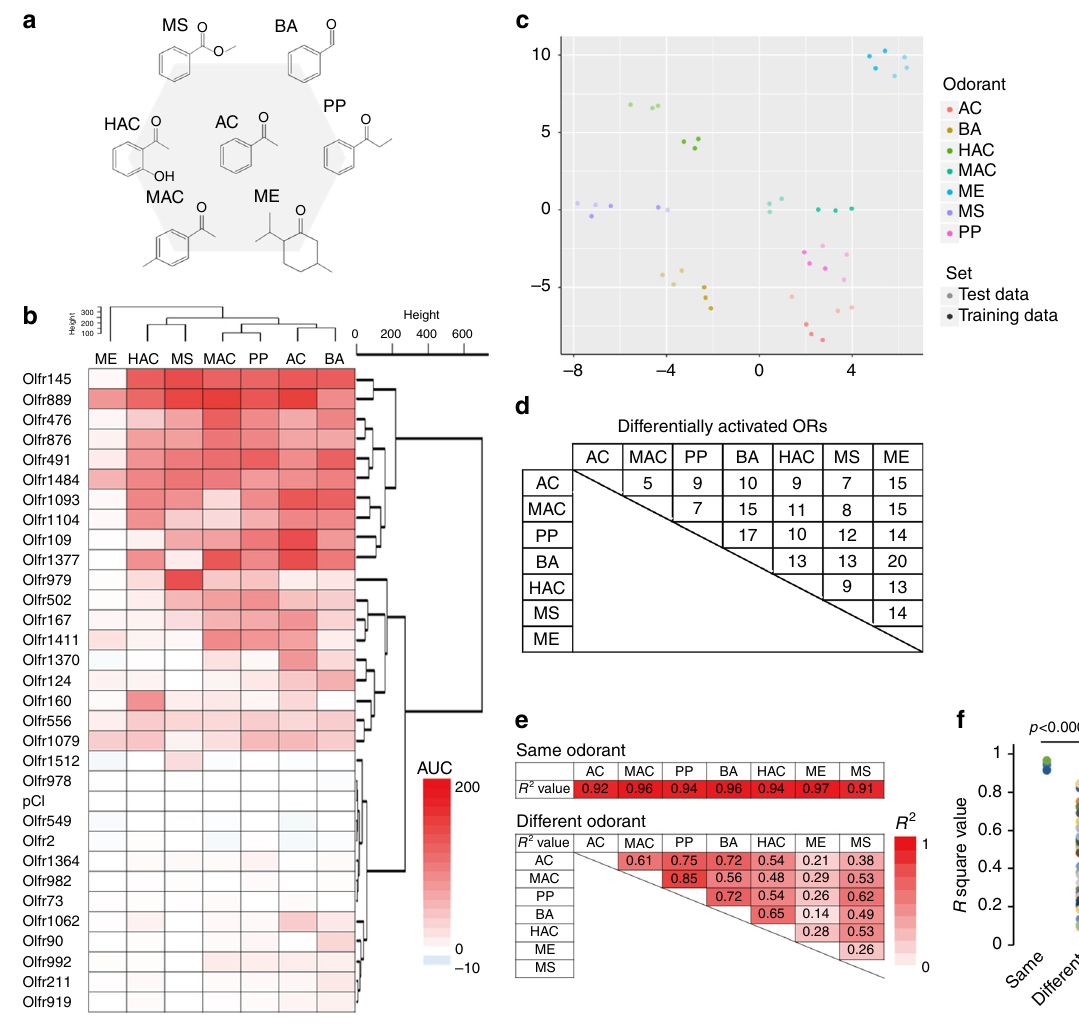
Fig. 6 Differential activation of ORs with acetophenone analogs. a Chemical structures of each acetophenone analog used in this study. b Heat map showing AUC of each OR stimulated with odorants at 10 – 2 dilution. The number on the left side indicates each OR. c The 32-dimensional space (31 ORs and a vector control) visualized using t – SNE. Each point is an odor with color representing the odor presented and saturation representing whether the point was used to train the model or was part of the test set. d The number of ORs that are differentially activated by tested odorant (Tukey ’ s post hoc analysis, p < 0.05). e Summary of the discrimination analysis using the same or different odorant pairs. Each R 2 value is shown in Supplementary Figures 20 and 21. f Difference of R 2 values between results with the same odorant in different experiments and different odorants in the same experiment Student ’ s t - test. AC acetophenone, MAC 4-methyl acetophenone, BA benzaldehyde, PP propiophenone, HAC 2-hydroxyl acetophenone, MS methyl salicylate,